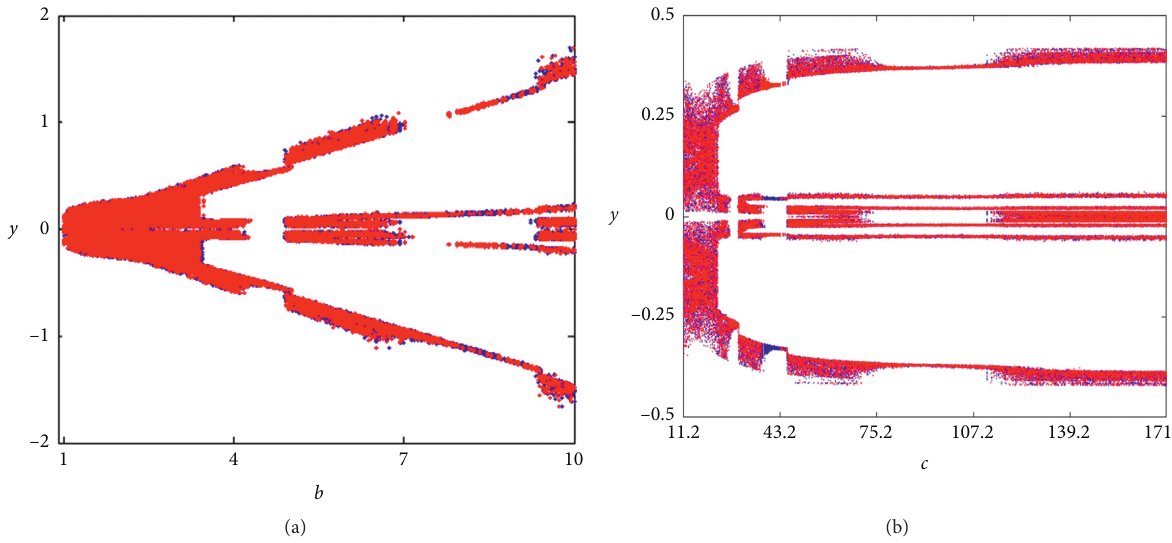
Figure 5: Bifurcation diagram of the proposed multiscroll chaotic system under mode 1: M ( − , +) with the initial condition ( x (0.01, 0.01, 0.01, 0.01) (blue case) and ( x 0 , y 0 , z 0 , w 0 ) = (0.01, − 0.01, − 0.01, 0.01) (red case). (a) Variation of b under a � 32 and c � 16; (b) variation of c under b � 2.4 and c �